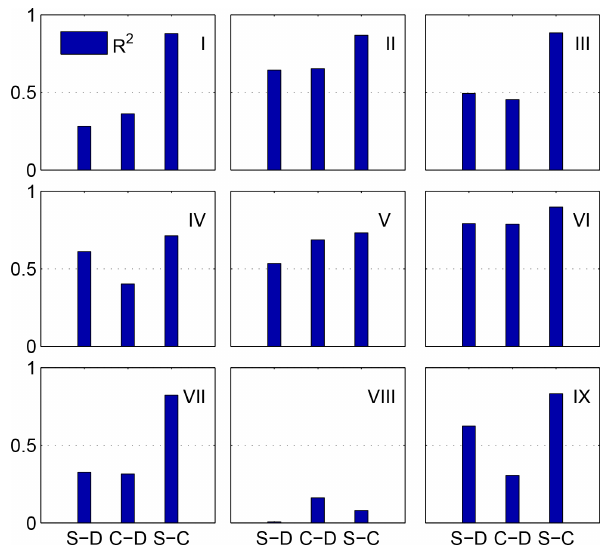
Figure 3. Similar to Fig. 2, but this statistical summary is for R 2